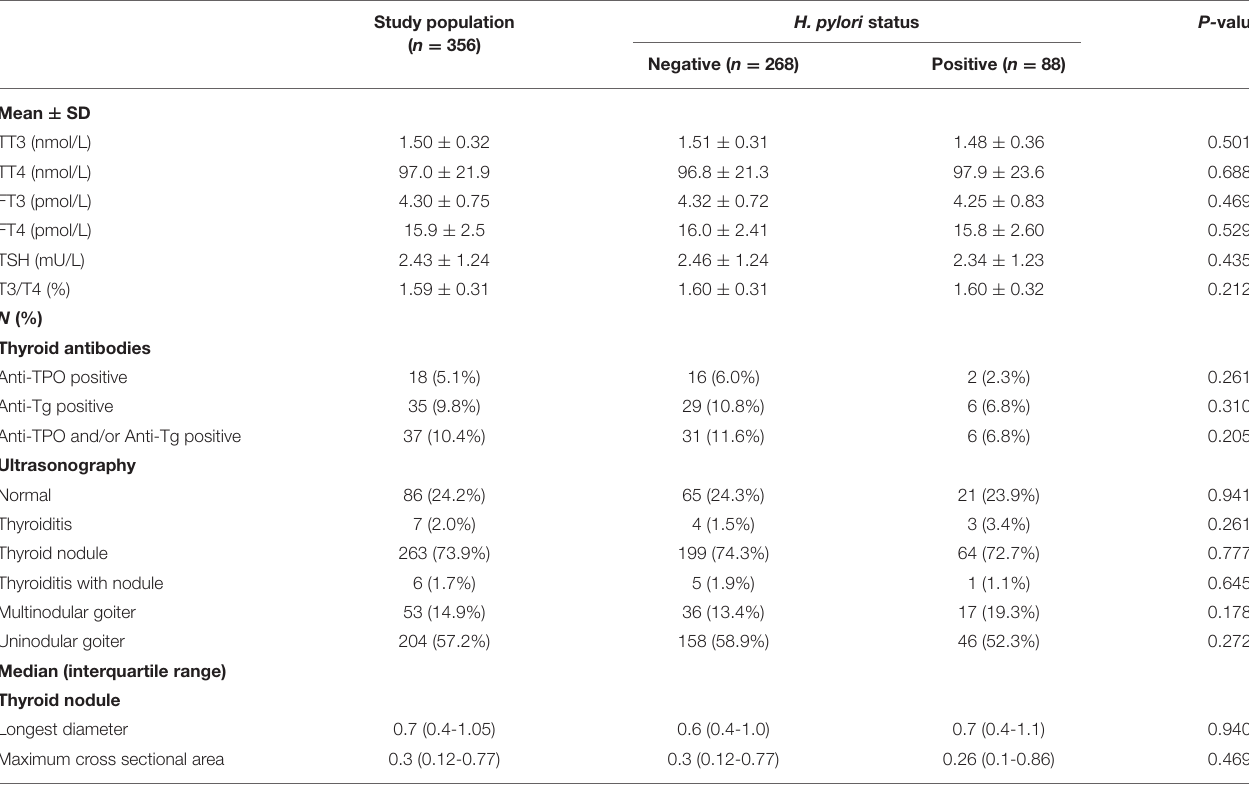
TABLE 2 | Results of thyroid tests of participants.